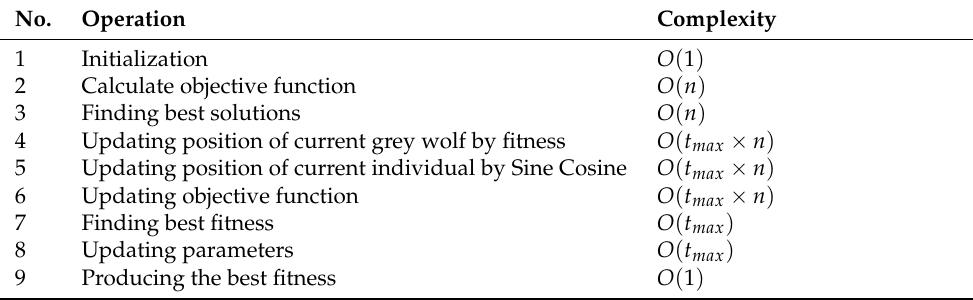
Table 3. ADSCFGWO algorithm’s computational